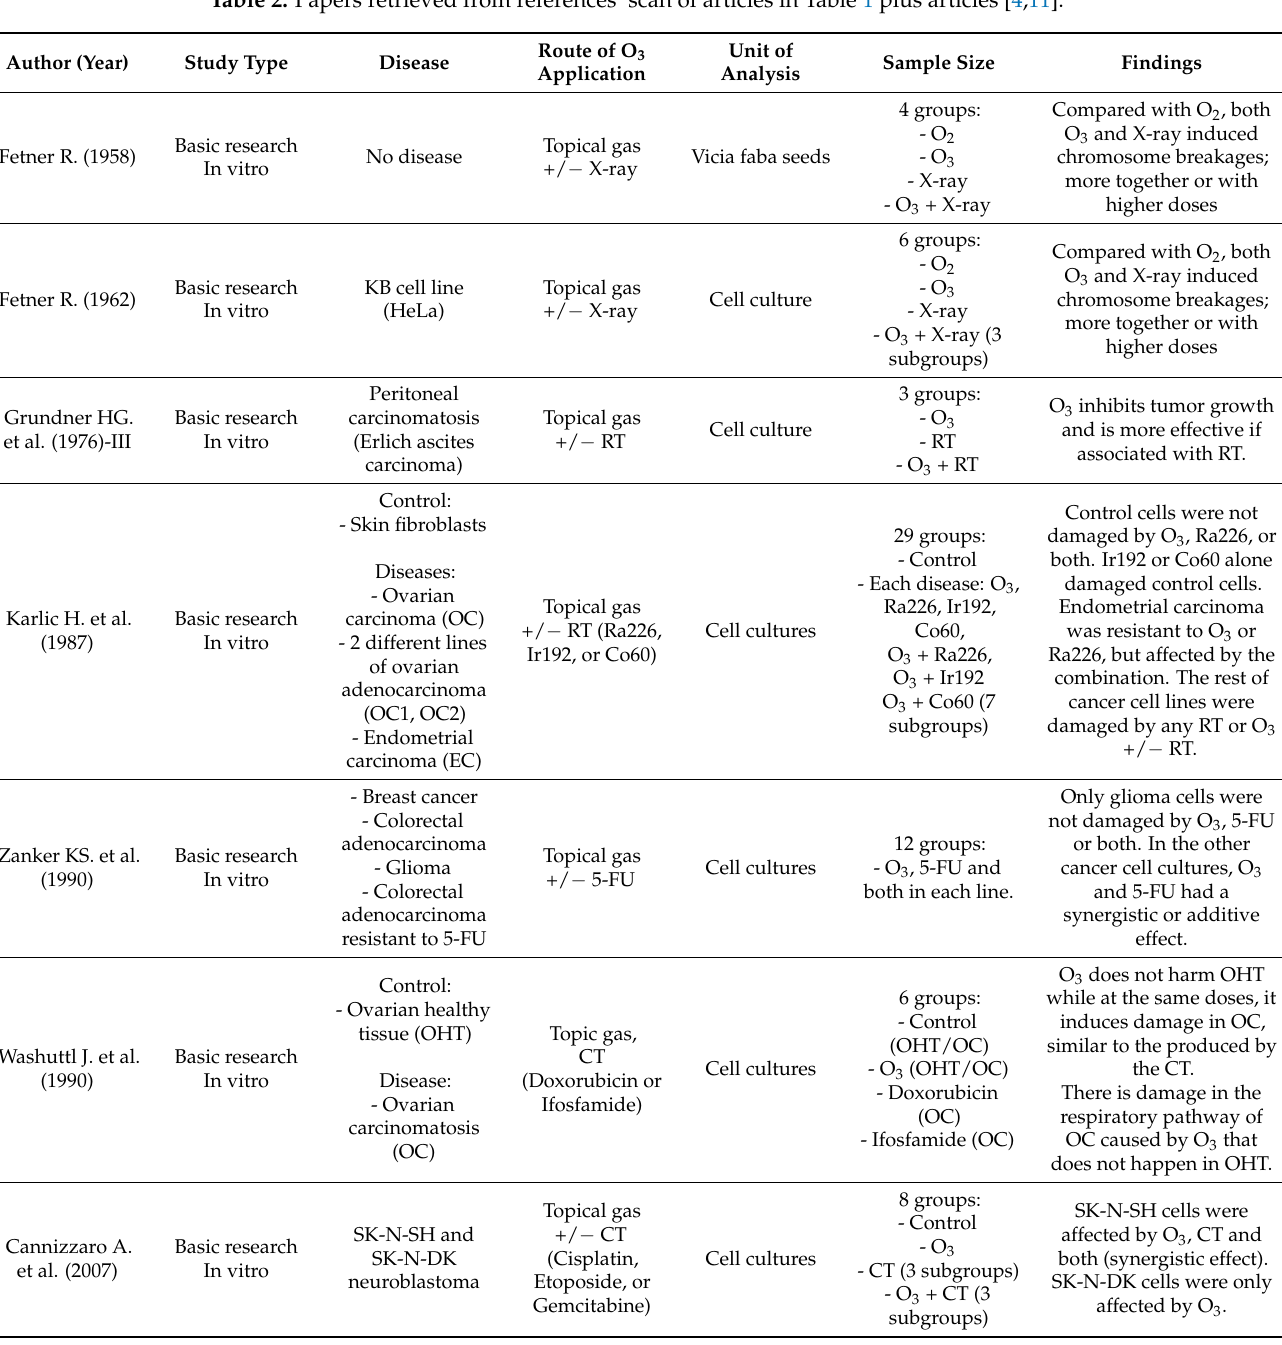
Table 2. Papers retrieved from references’ scan of articles in Table 1 plus articles